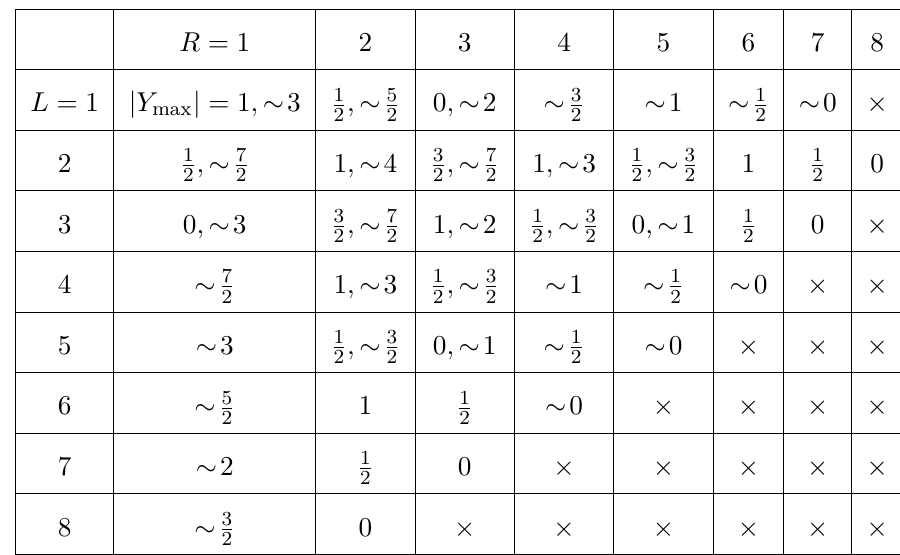
Table 4 . The representations of scalar BSM Loryons still viable after considering constraints on κ γ . A ∼ means the representation requires flipping the sign of κ γ .